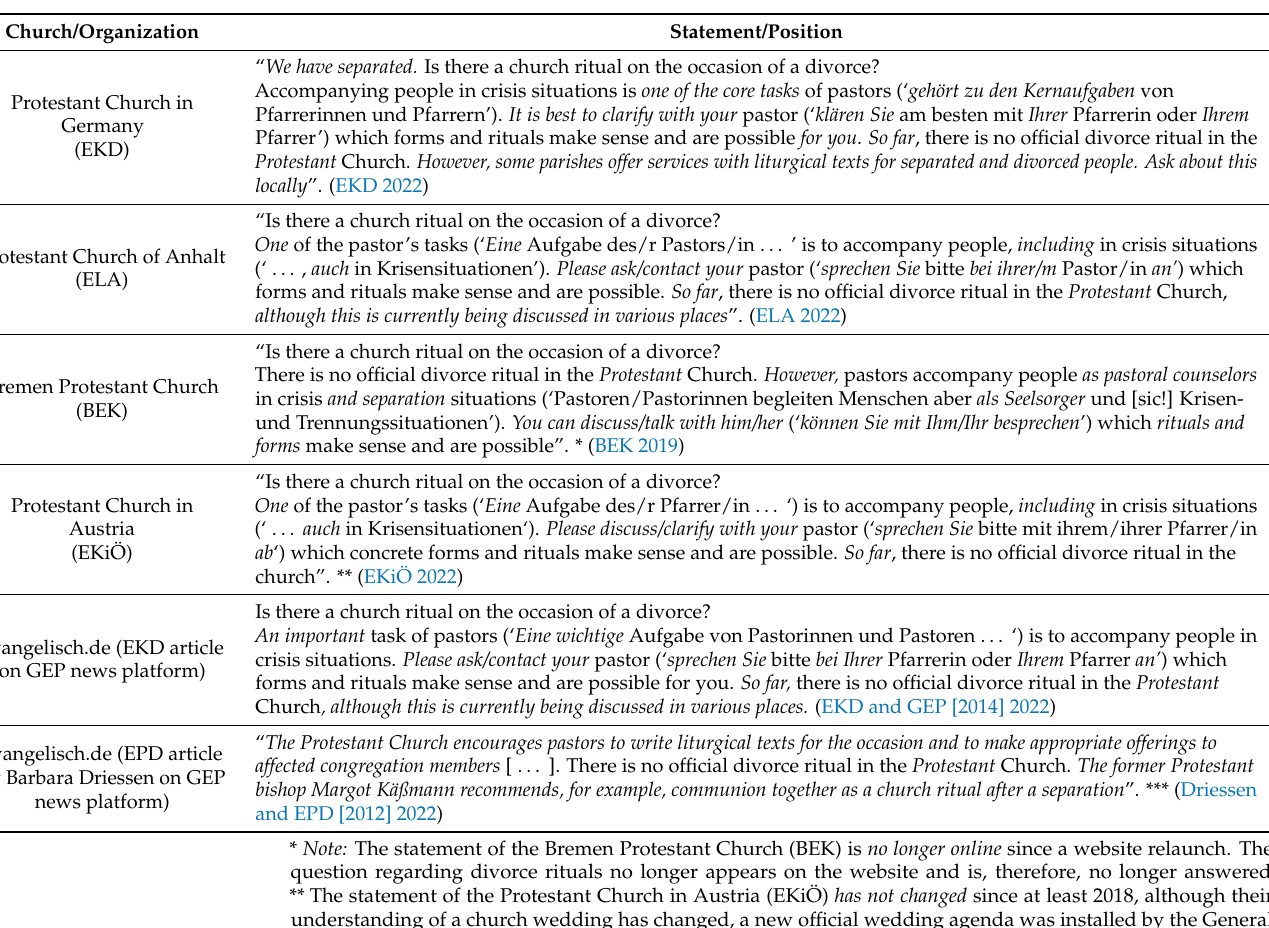
Table 2. Statements regarding divorce rituals on regional/national church